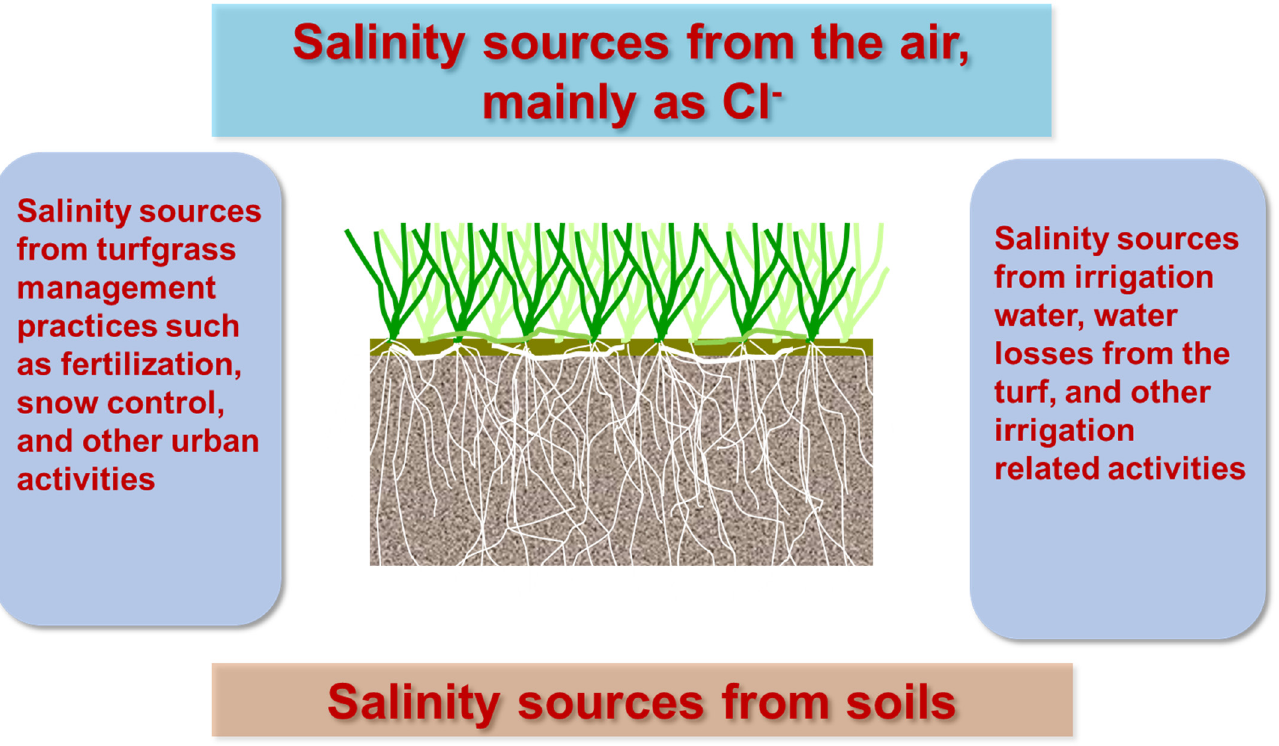
Figure 2. Multiple sources contribute to the salinity stresses of a turfgrass community, and these sources vary depending on location conditions.